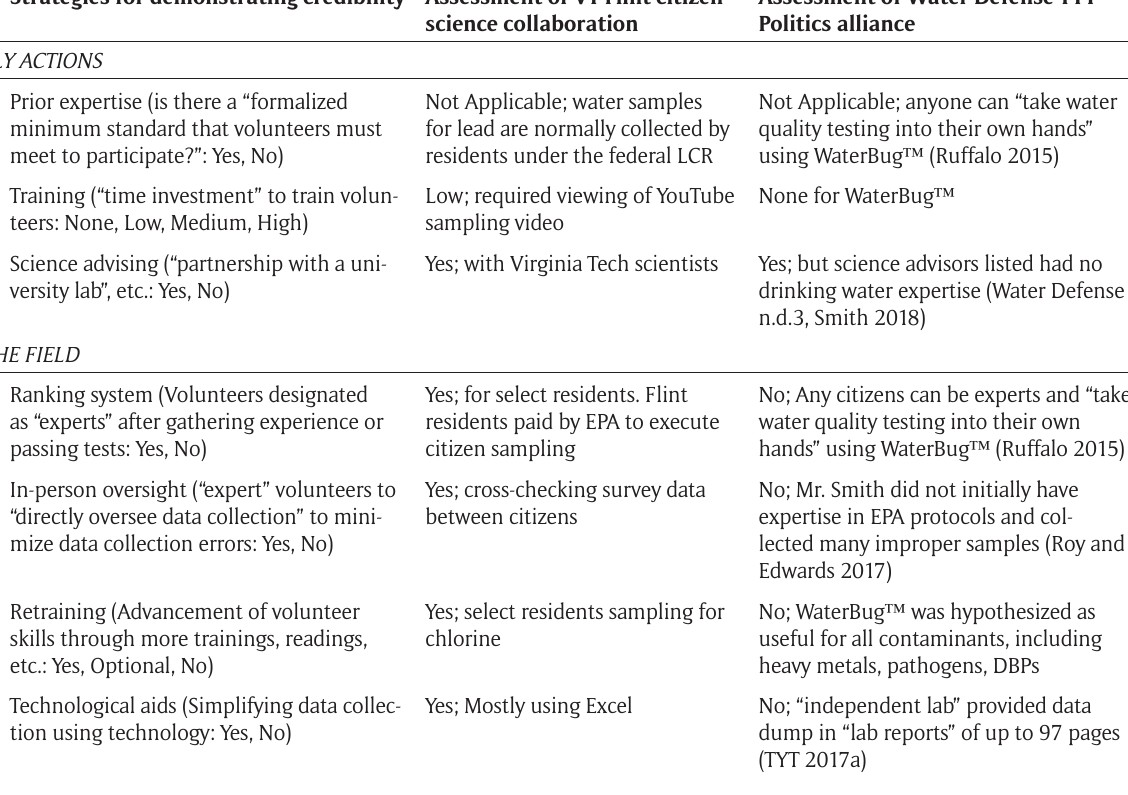
Table 2: Strategies from Freitag and colleagues (2016) used to assess the initial Virginia Tech-Flint residents citizen sci- ence collaboration and Water Defense-TYT Politics